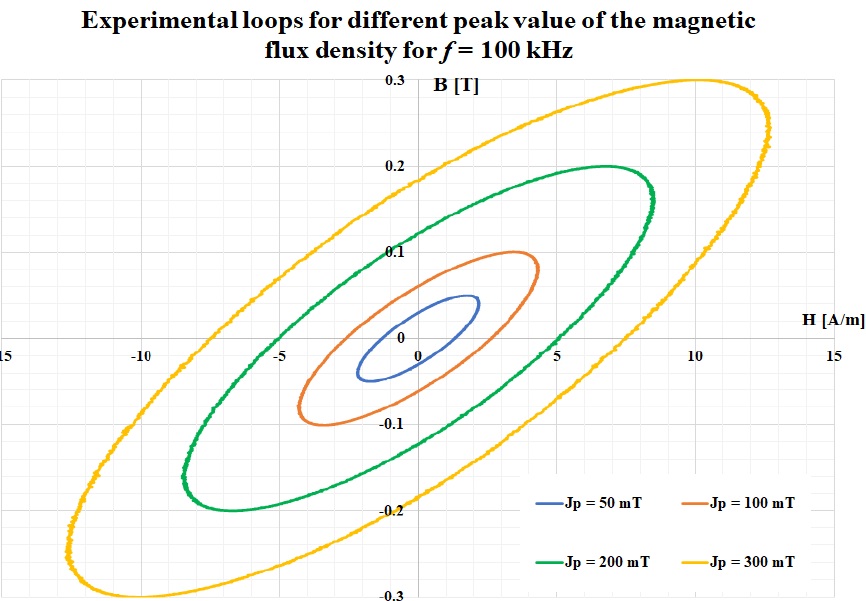
Figure 4. Comparison between experimental loops for different values of the magnetic flux density obtained at 100 kHz.